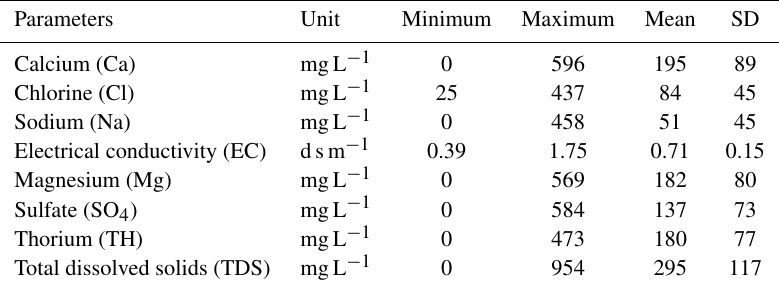
Table 1. Descriptive statistics of the parameters for evaluation of water quality (Fars Regional Water Authority).